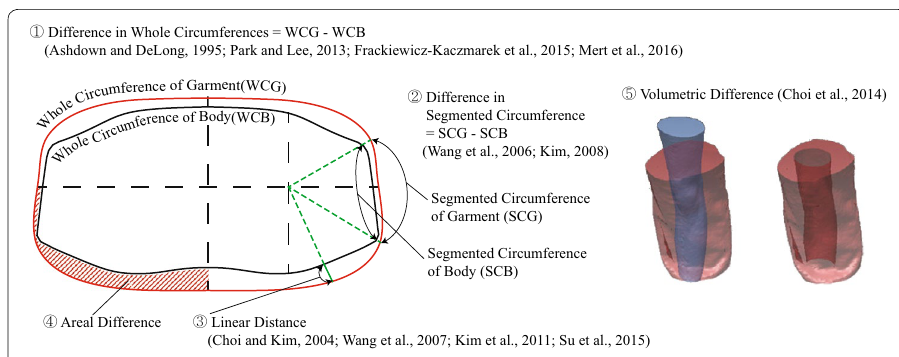
Fig. 2 Quantification methods of the ease allowance. Figure shows the ease allowance quantification methods of the previous studies. ① shows the difference in the entire circumference between the garment and human body. ② shows the difference between the garment size and human body size measured separately for a specific segment of the circumference. ③ shows the linear distance between the human body and the garment measured along a reference line. ④ shows difference in two-dimensional area between the human body and the garment directly calculated along the cross-sectional plane. ⑤ shows the difference in three-dimensional volume between the garment and the human